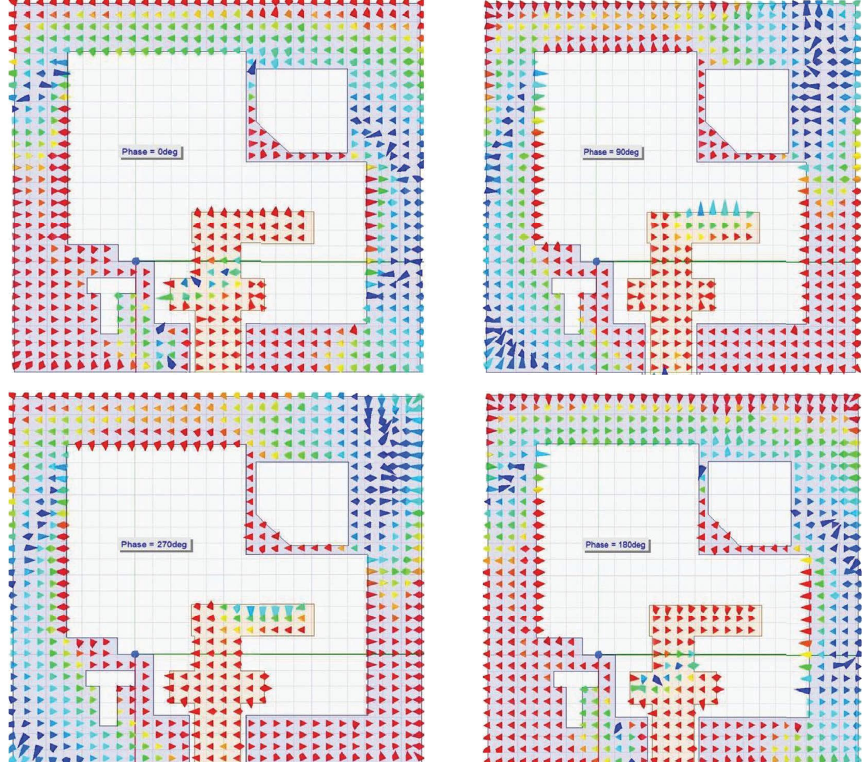
Figure 6: Circular polarization at 5.7 GHz.